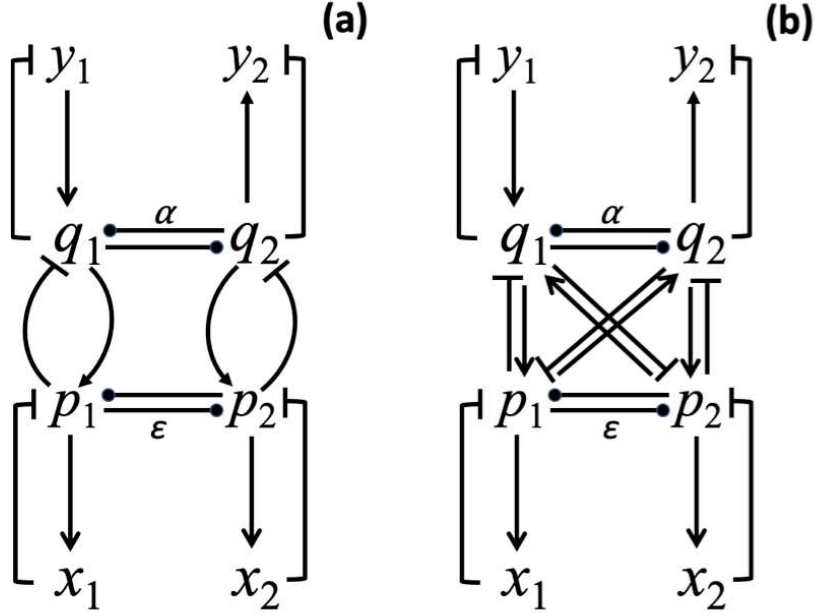
Figure 1. Two different influence schemes for processes described by the system of Equation (1). ( a ) Binding between 𝑃(cid:4652)⃗ and 𝑄(cid:4652)⃗ sets of processes is gained through interaction of 𝑝 (cid:2869) with 𝑞 (cid:2869) and 𝑝 (cid:2870) with 𝑞 (cid:2870) processes. In neural systems such specific winning links can be established via training in response to different combinations of input stimuli. Here, negative feedback loops are used to realize connections between 𝑝 (cid:2869) and 𝑞 (cid:2869) as well as between 𝑝 (cid:2870) and 𝑞 (cid:2870) . ( b ) Binding between 𝑃(cid:4652)⃗ and 𝑄(cid:4652)⃗ sets of processes in which all 𝑝 (cid:2869) , 𝑝 (cid:2870) , 𝑞 (cid:2869) , 𝑞 (cid:2870) processes are mutually interconnected via negative feedback loops. Arrow-headed lines represent a positive influence and bar-headed lines represent a negative influence. The dot-headed lines represent positive or negative influence depending on the sign of the α and ε parameters.